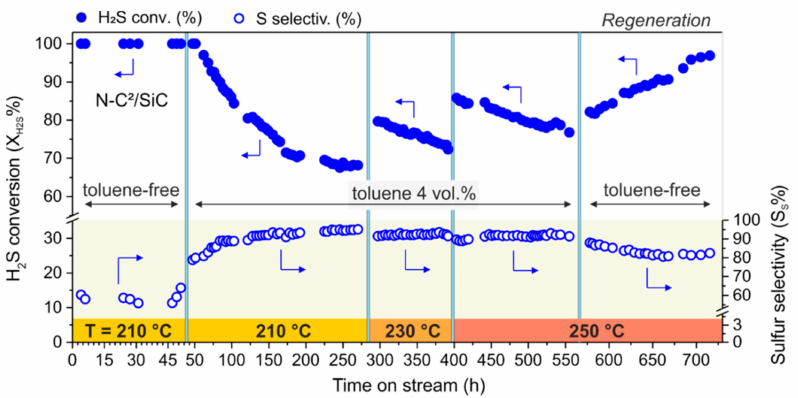
Figure 4. Effect of the temperature on the desulfurization performance of N-C 2 /SiC using an acid gas stream ([H 2 S] = 0.3 vol.%) in the presence of 40,000 ppm of toluene (4 vol.%) as contaminant. The first 47 h on stream were operated under toluene-free conditions. Catalysis details: 6 g (V cat ~ 7.5 cm 3 of N-C 2 /SiC); O 2 -to-H 2 S ratio = 2.5, [H 2 O] = 10 vol.%, He (balance); GHSV (STP) = 3200 h − 1 . Catalyst regeneration (last 150 h on stream) occurs upon switching-off the toluene content from the acid gas